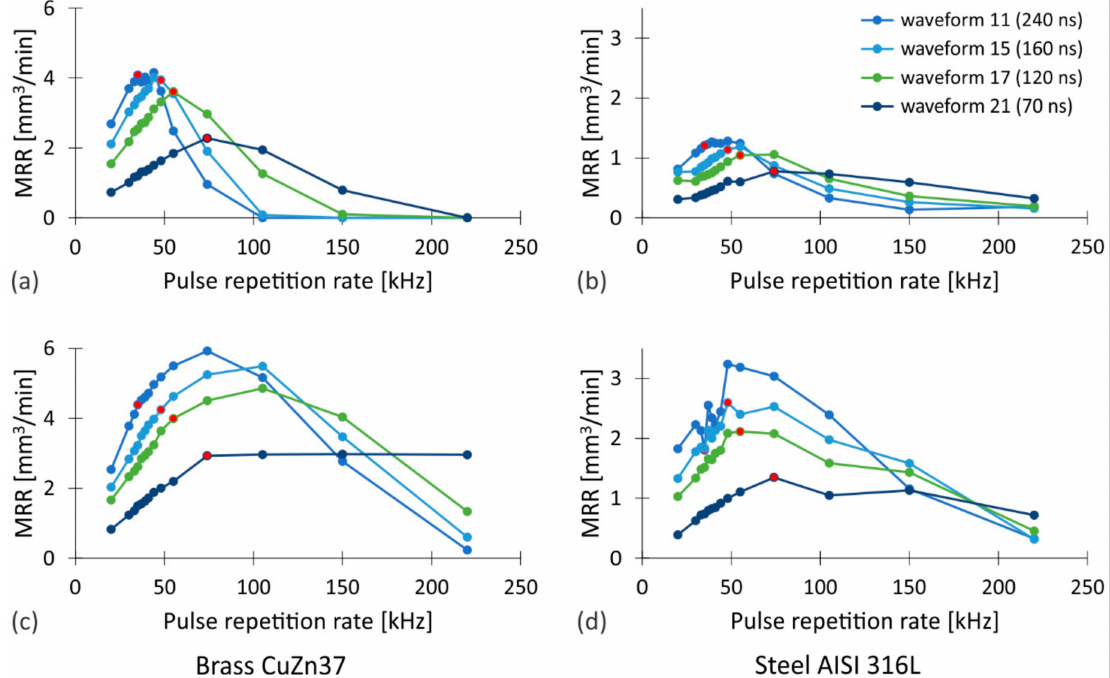
Figure 2. The evolution of MRR as a function of the pulse repetition rate and the pulse duration when processing ( a , c ) brass CuZn37 and ( b , d ) steel AISI 316L using two sets of pulse fluences of ( a , b ) 20 J/cm 2 and ( c , d ) 45 J/cm 2 . The repetition rates corresponding to the f 0 of the selected waveforms are marked with the red